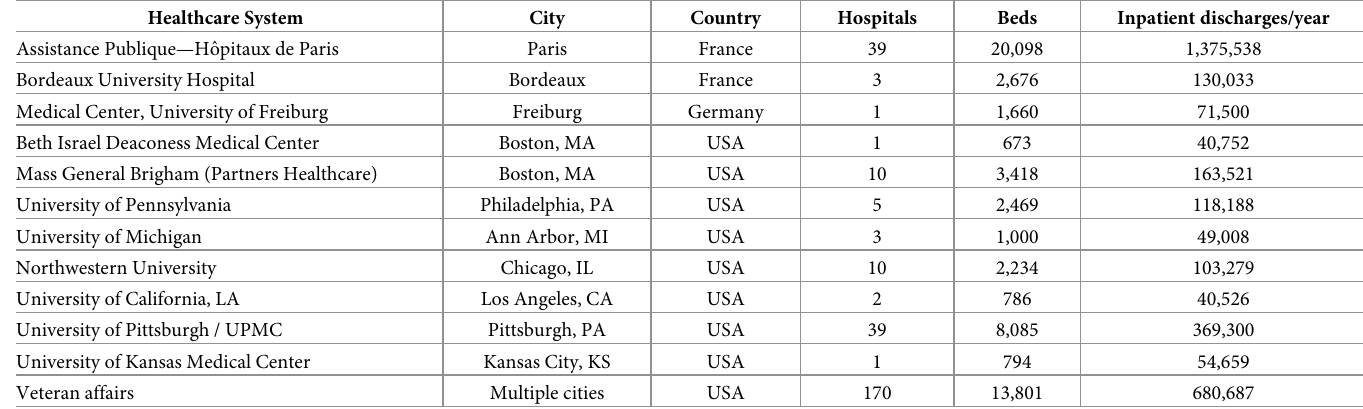
Table 1. Name, city, country, number of hospitals per HS, number of beds and inpatient discharges/year per HS. Healthcare